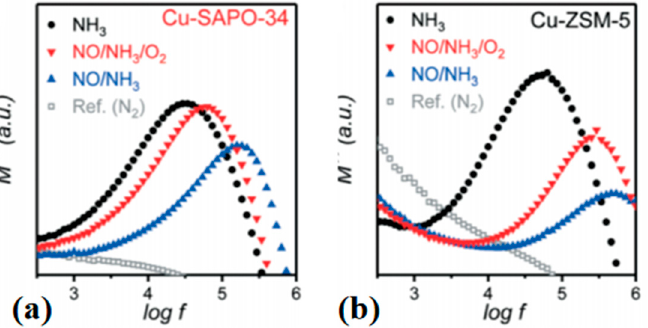
Figure 10. High-frequency resonance peaks in the modulus plots of ( a ) Cu-SAPO-34 and ( b ) Cu- ZSM-5 exposed to different gas atmospheres at 175 °C. NH 3 : 100 ppm in N 2 ; NO: 100 ppm in N 2 ; and O 2 : 10 vol% in N 2 . Cu-ZSM-5: Si/Al 13.5, Cu/Al 0.136; Cu-SAPO-34: [Al + P]/Si 11.2, Cu/Si 0.131. Reproduced with permission from [74], copyright American Chemical Society, 2018.